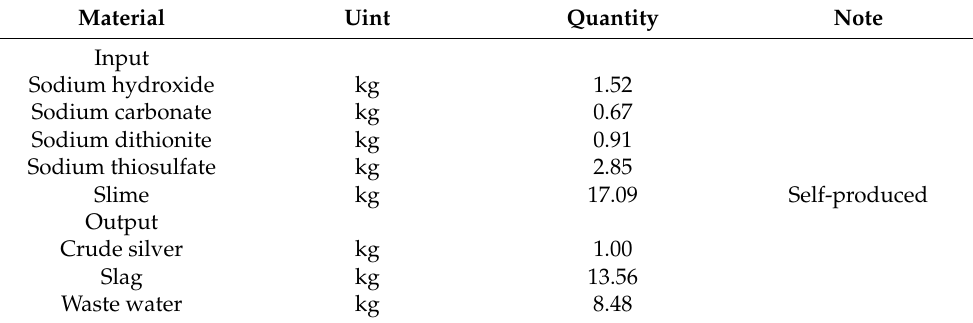
Table 2. Material inventory of new silver separation process.